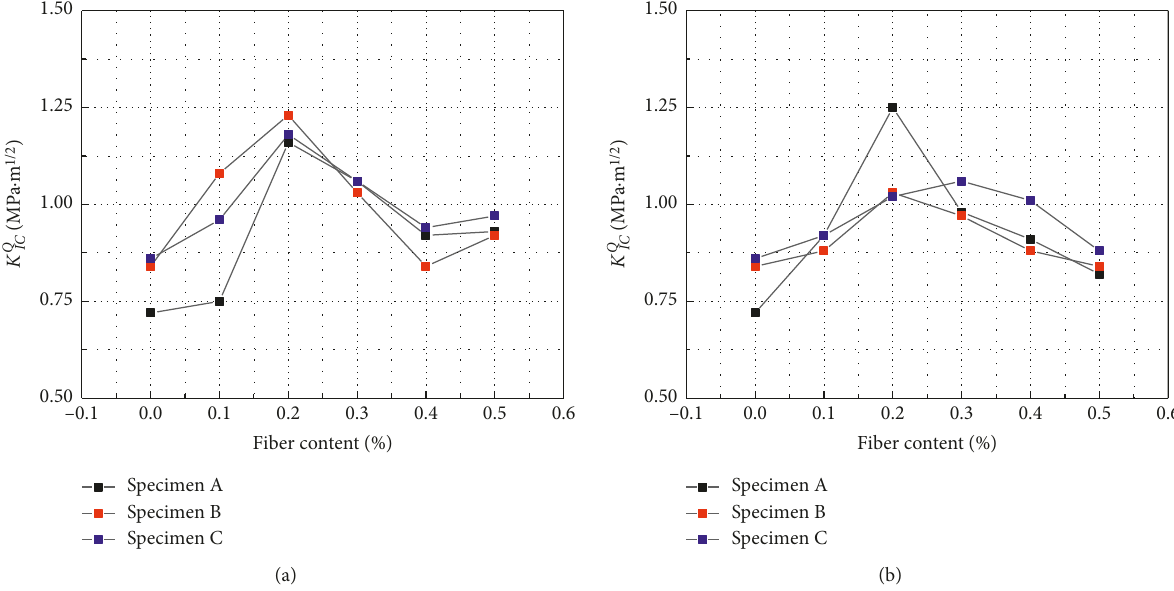
Figure 4: Initiation toughness vs. basalt fiber dosage. (a) The fiber length is 6mm. (b) The fiber length is 12